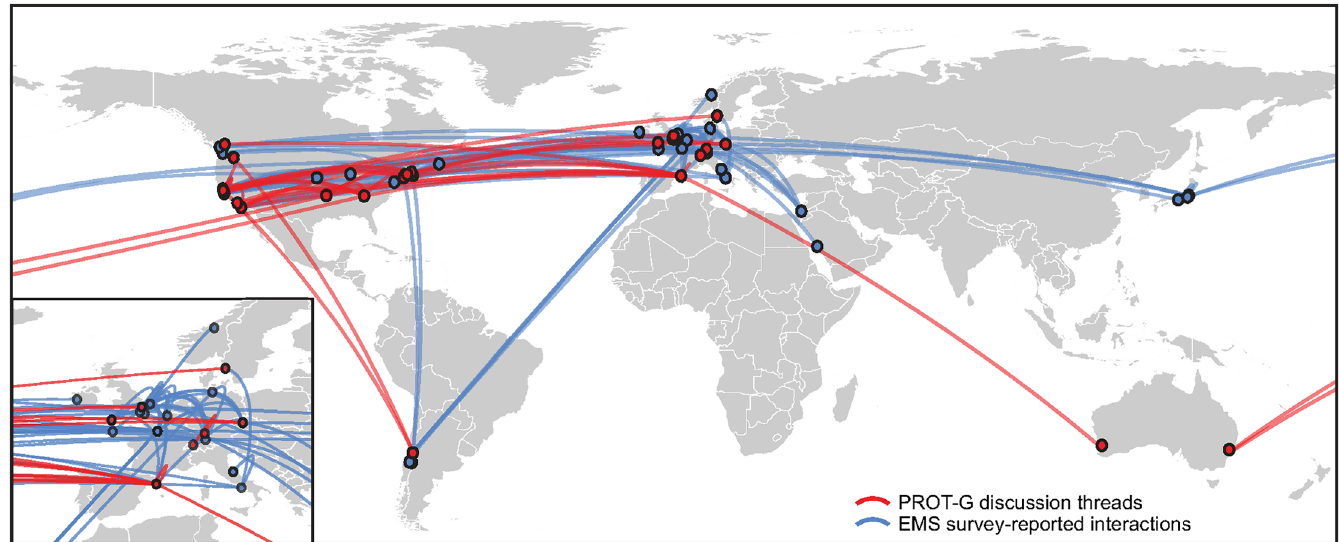
Fig 3. Global EMS network map of protocols.io PROT-G discussion threads (red) and further direct discussions and interactions (blue) between program teams reported in the EMS survey. EMS, Experimental Model Systems; PROT-G, Protist Research to Optimize Tools in Genetics.